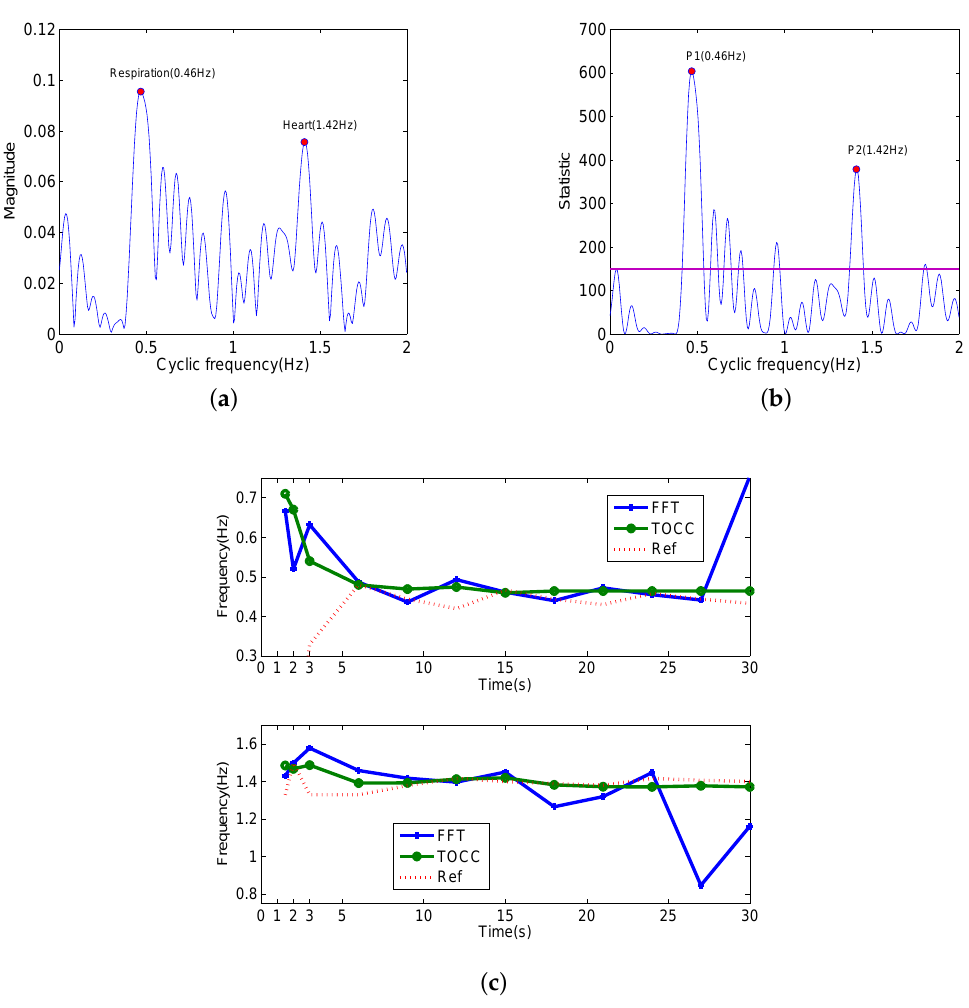
Figure 8. TOCC of the received radar signal. ( a ) TOCC 2-D graph; ( b ) Test statistic (purple line denotes the threshold, here PFA = 0.001); ( c ) The detected results of the heart and respiration rates with the record time increased in the 3 s steps (bottom: heart, top: respiration, Ref indicates the